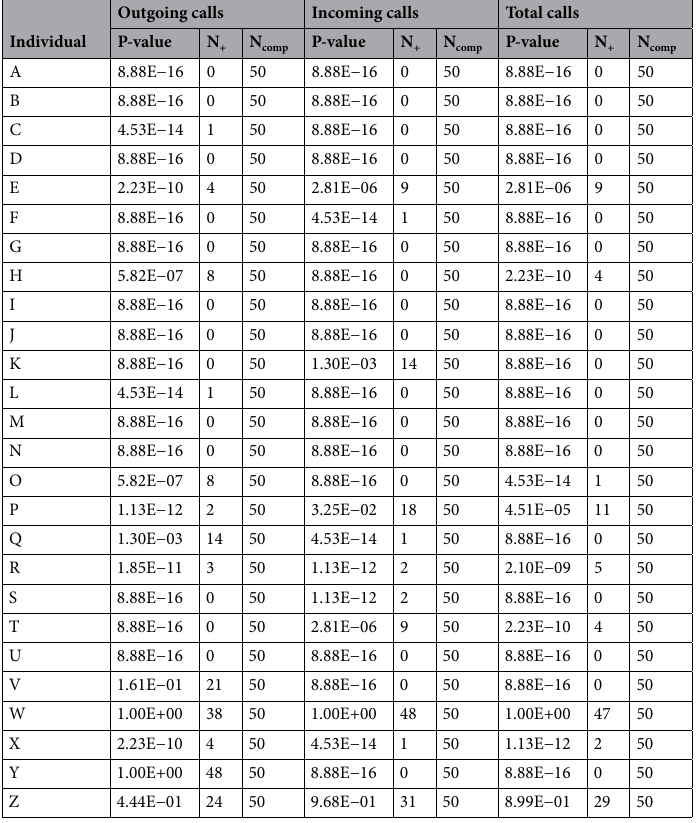
Table 1. Results of statistical tests of persistence. The results comprise three different cases: (1) outgoing, (2) incoming, and (2) total calls test of persistence. The p-value corresponds to the one obtained with a sign test. N + correspond to the number of inter-individual dissimilarities lower than the intra-dissimilarity. N comp corresponds to the number of comparisons